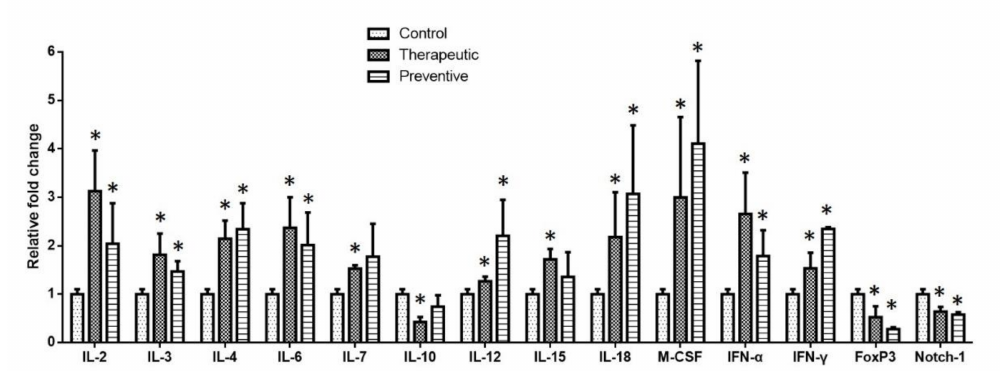
Figure 5. Effects of GF-EPS on cytokine mRNA expression levels in the spleen of tumor-bearing mice. After sacrifice, total RNA from each mouse colon was prepared for RT-PCR. The mRNA levels of (A) IL-2, Il-3, IL-5, IL-7, IL-10, IL-12, IL-15, IL-18, M-CSF, IFN α , IFN γ , Foxp3, and Notch1 were determined via qRT-PCR. Values are represented as folds of the control group. Data are expressed as the mean ± SD. Differences compared with the control group with statistical significance at p < 0.05